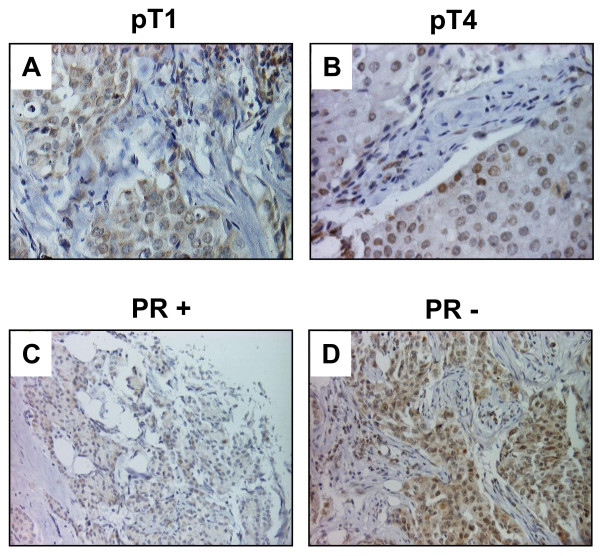
Representative tissue microarray staining results illustrating YB-1 expression in relation to tumor stage (A and B) and progesterone receptor status (C and D). A and B: While YB-1 staining in small (pT1) tumors is predominantly cytoplasmic (A), large (pT4) tumors preferentially show a distinct condensation of YB-1 signal in the nuclei of tumor cells (B). C and D: In breast tumors with positive progesterone receptor status (C) YB-1 expression is predominantly cytoplasmic, while tumors that lost progesterone receptor expression (D) exhibit prominent nuclear YB-1 expression.